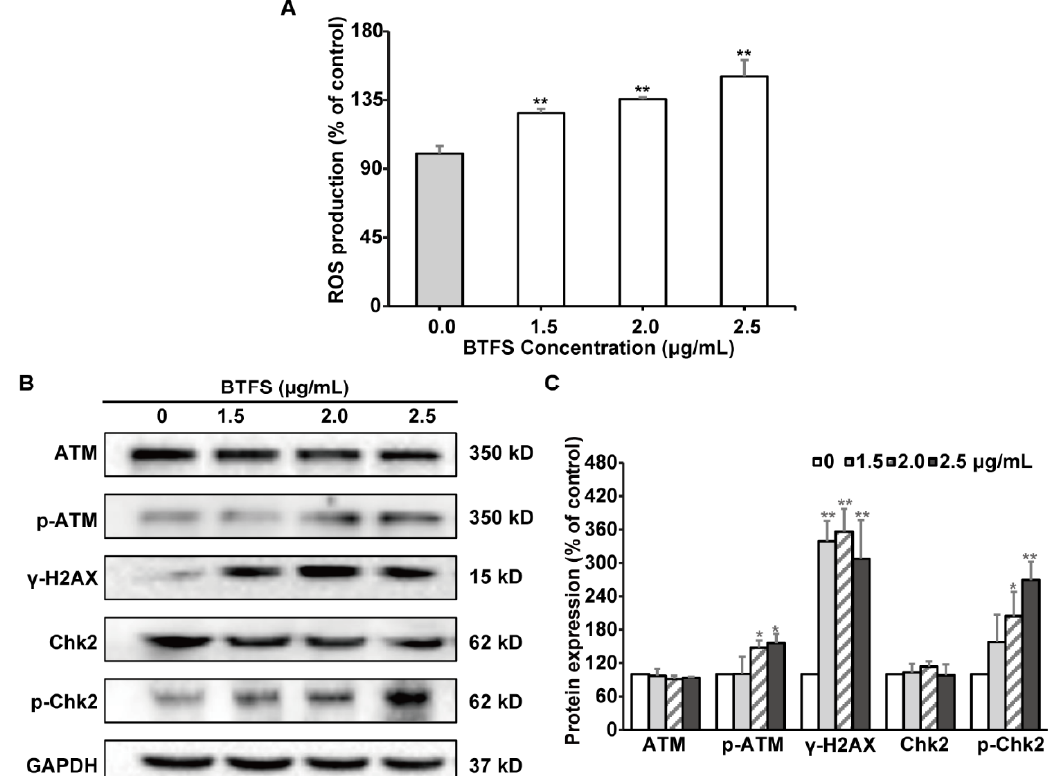
Figure 6. BTFS caused DNA damage in A2780 / CP70 cells. ( A ) The e ff ect of BTFS 3 on ROS production in A2780 / CP70 cells. * p < 0.05; ** p < 0.01 versus control. ( B , C ) The e ff ect of BTFS on the expression